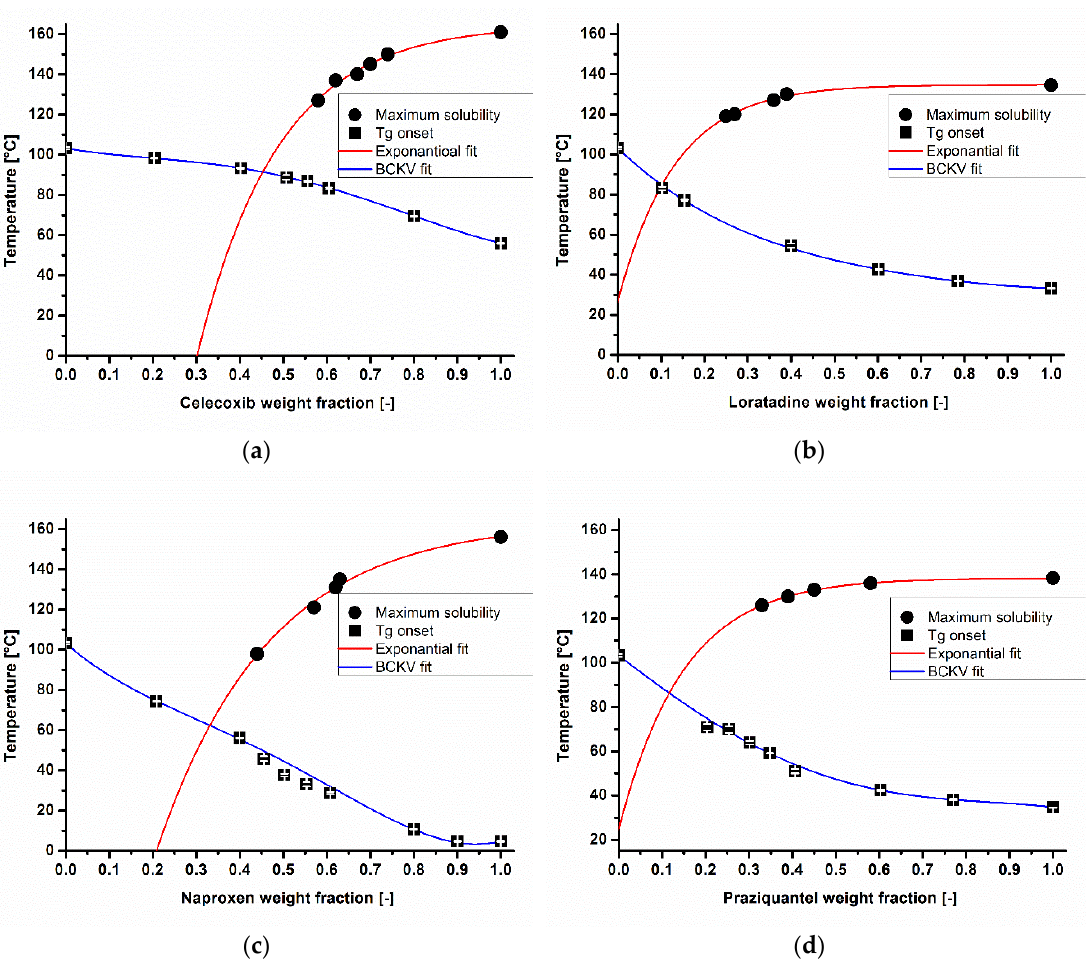
Figure 2. Phase diagrams of celecoxib ( a ), loratadine ( b ), naproxen ( c ), and praziquantel ( d ) in copovidone.